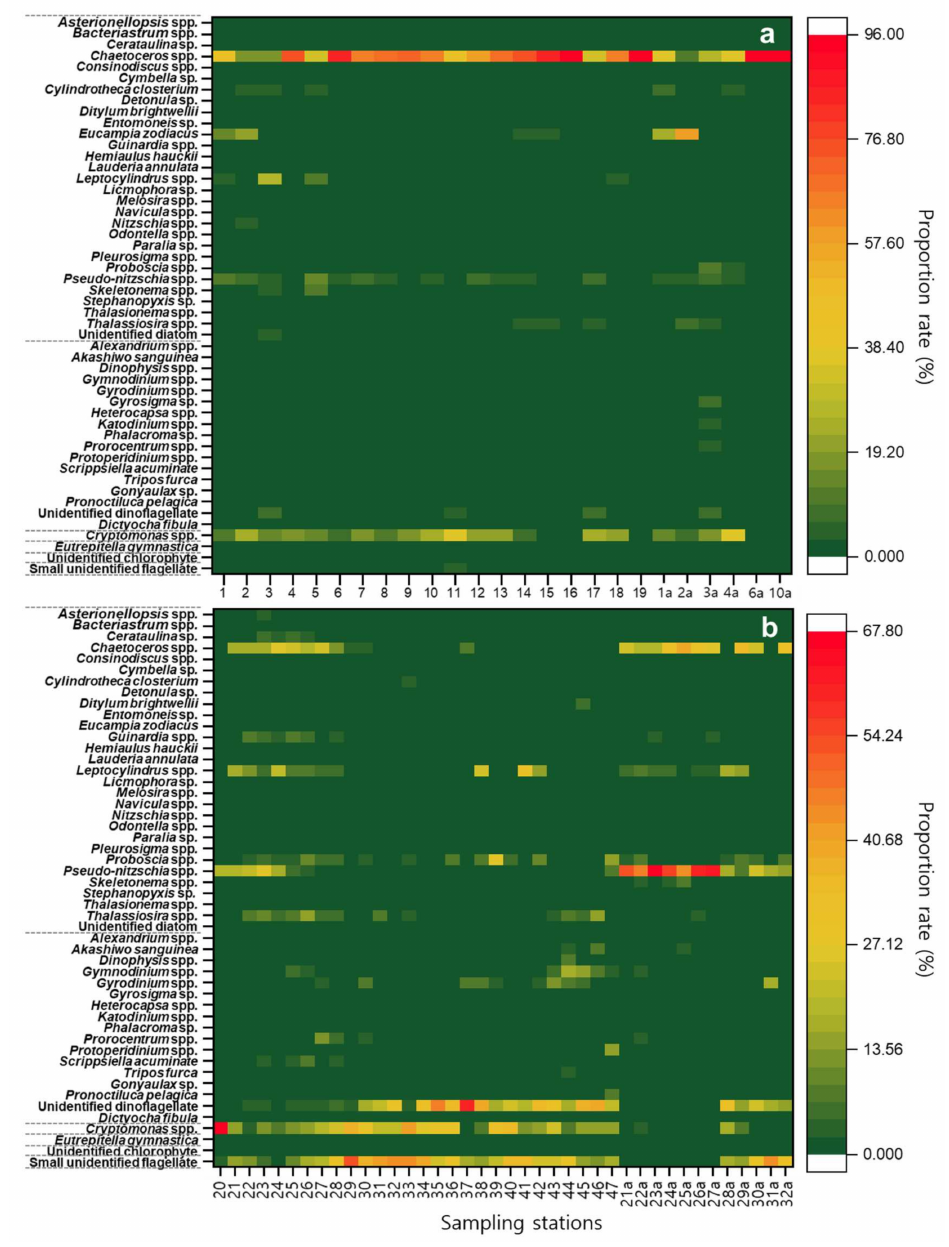
Figure 10. Horizontal distribution of different phytoplankton species during early spring ( a ) and late spring ( b ) at all sampling stations in the East